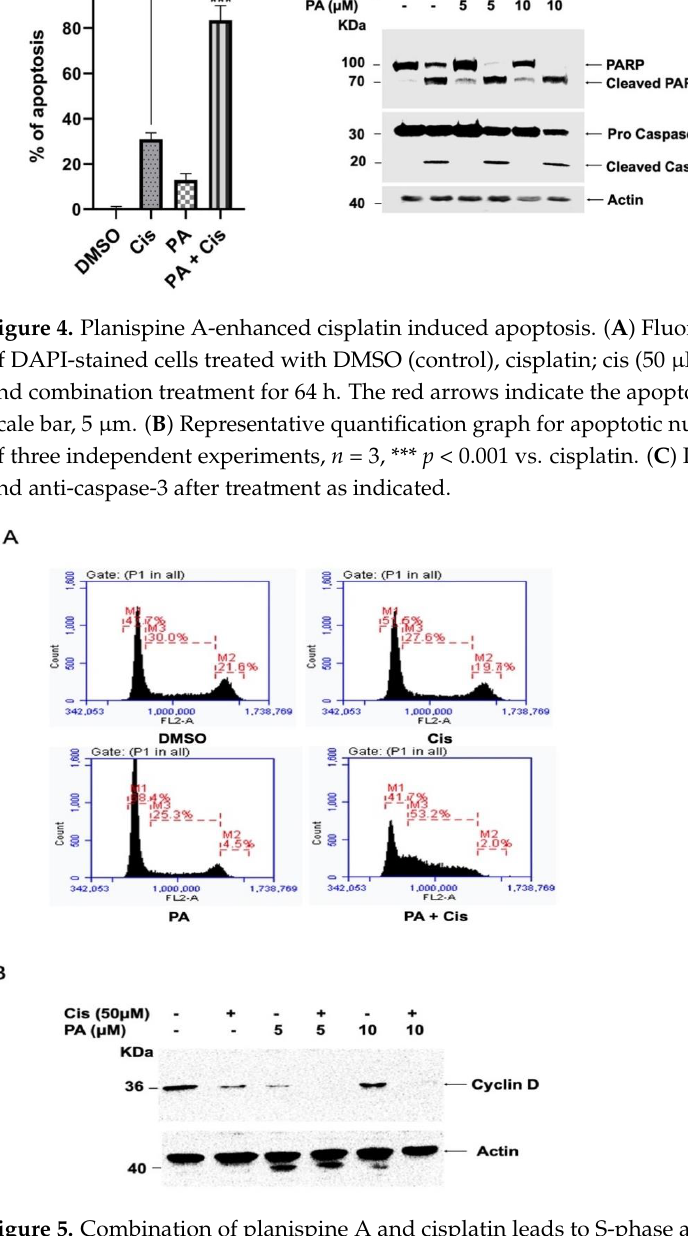
Figure 5. Combination of planispine A and cisplatin leads to S-phase arrest. ( A ) Cells were treated with DMSO (control), cisplatin; cis (2 µM), planispine A;PA (3 µM) and a combination. Cells were fixed with 70% ethanol and stained with Propidium iodide and cell cycle was determined by flow cytometry. ( B ) Immunoblot showing expressions of cyclin D1 after treatment as indicated.